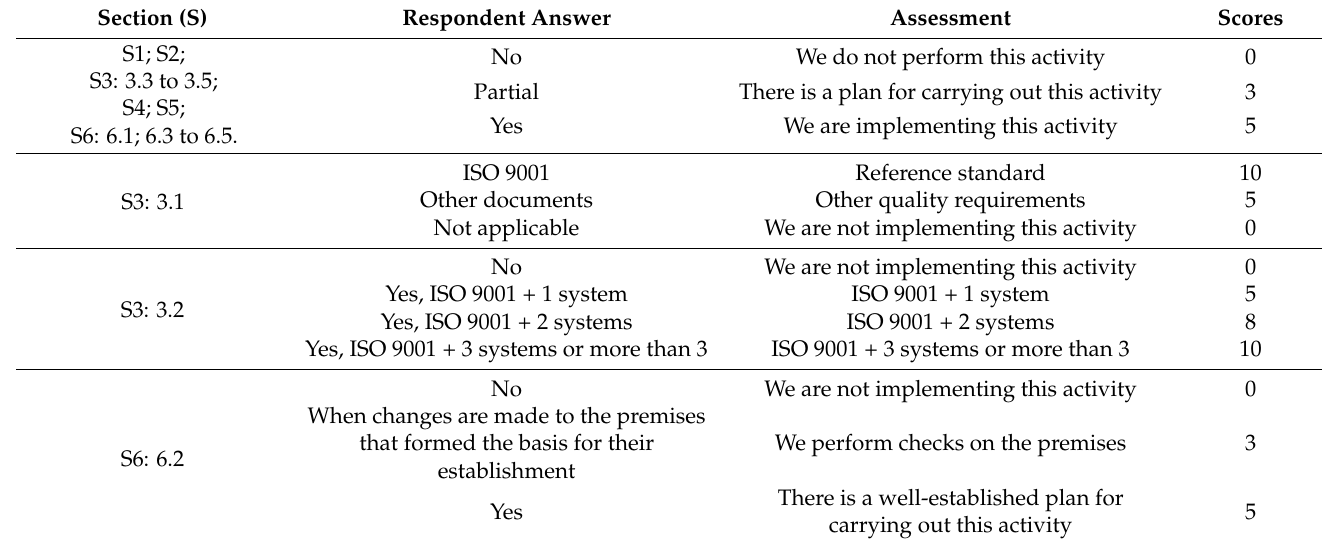
Table 1. Evaluation rules on Sections 1–6 of